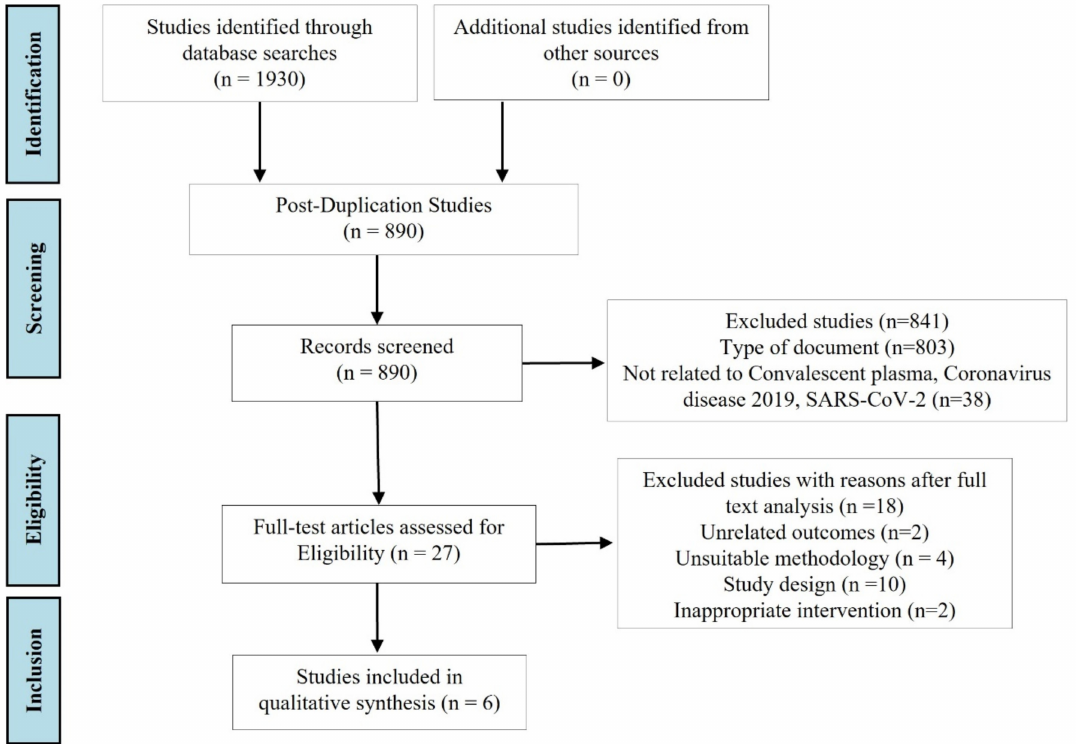
Figure 1. Preferred Reporting Items for Systematic Reviews and Meta-Analyses (PRISMA) flow diagram study selection process for the systematic